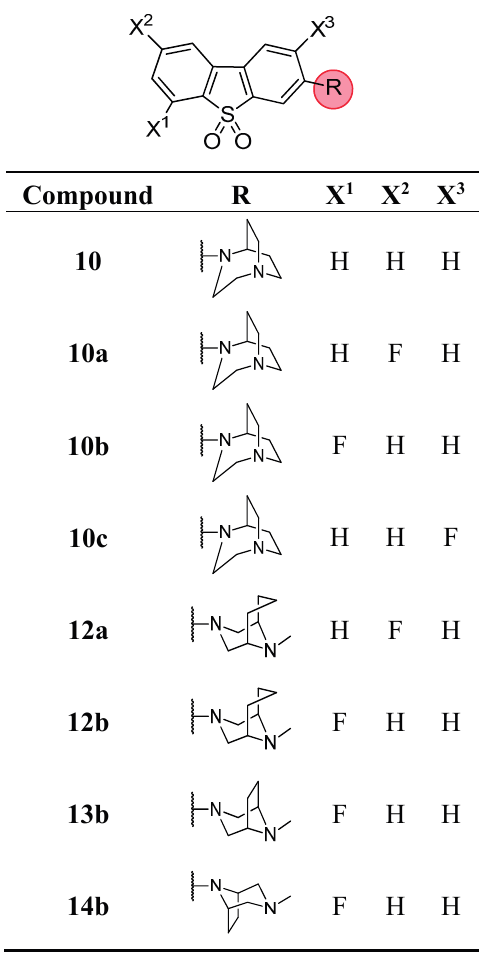
Table 1. Structures of fluoro-substituted dibenzothiophene-based ligands for α 7